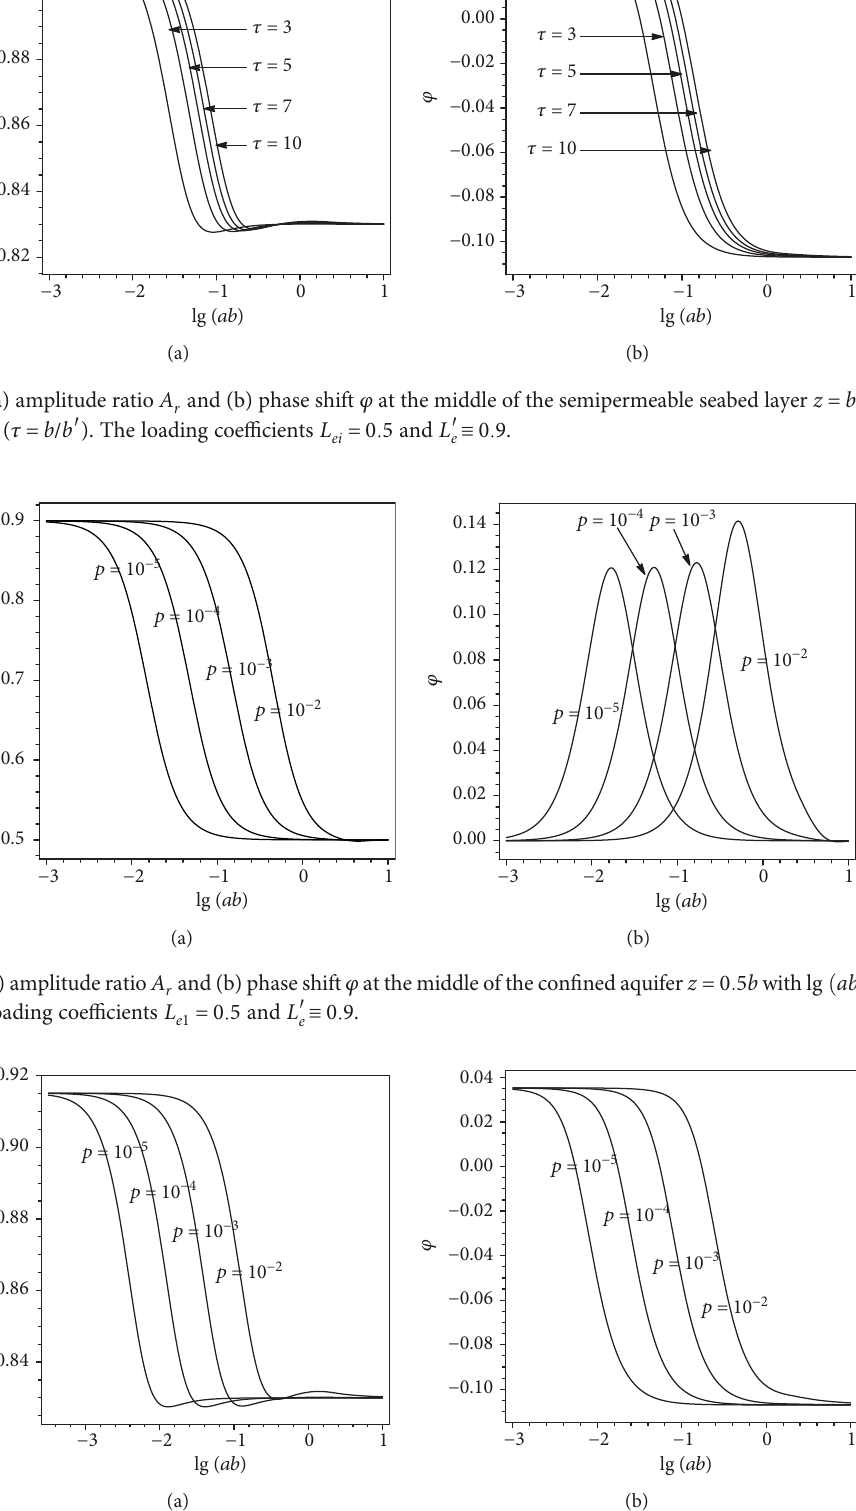
and (b) phase shift φ at the middle of the seabed semipermeable layer z = b + 0 5 b ′ with lg ab r ′ ≡ ). The loading coe ffi cients L and L 0 9 . e 1 = 0 5 e 1